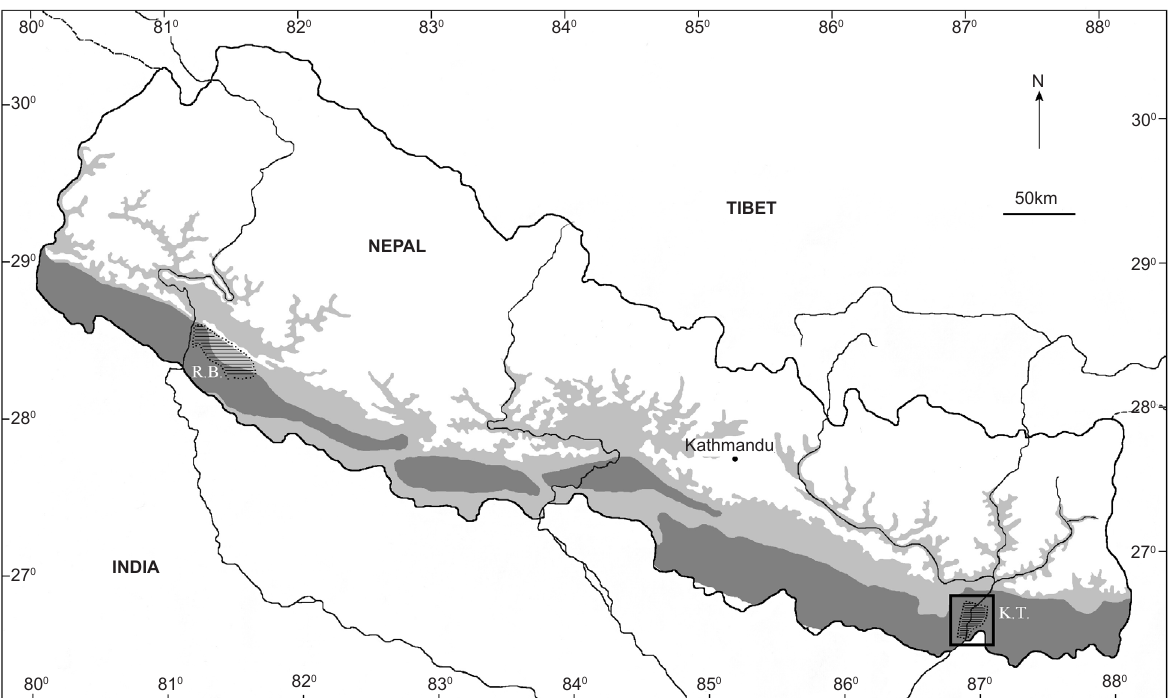
Figure 1. Map of Nepal showing the location of Koshi Tappu WR (K.T.) and Royal Bardia NP (R.B.) and the delineation within the country’s borders of the terrestrial ecoregions, Terai-Duar Savanna and Grasslands (area shaded dark grey) and Himalayan subtropical broadleaf forests (area shaded light grey). The area within the black box is depicted in greater detail in Fig.